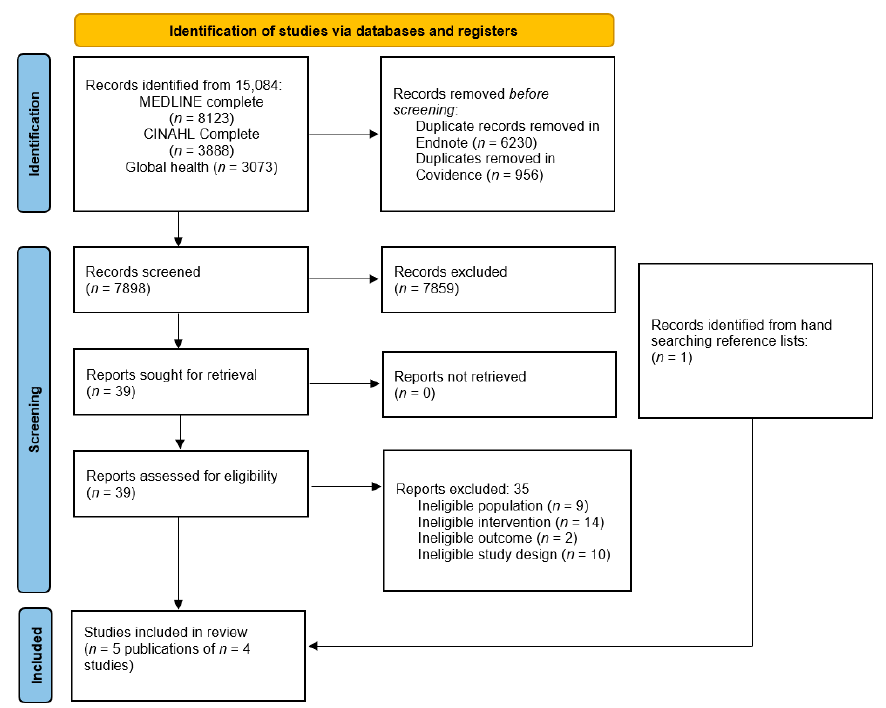
Figure 1. PRISMA flow diagram of included studies for the systematic review of new or innovative nutrition products used in hospital and aged care foodservices.